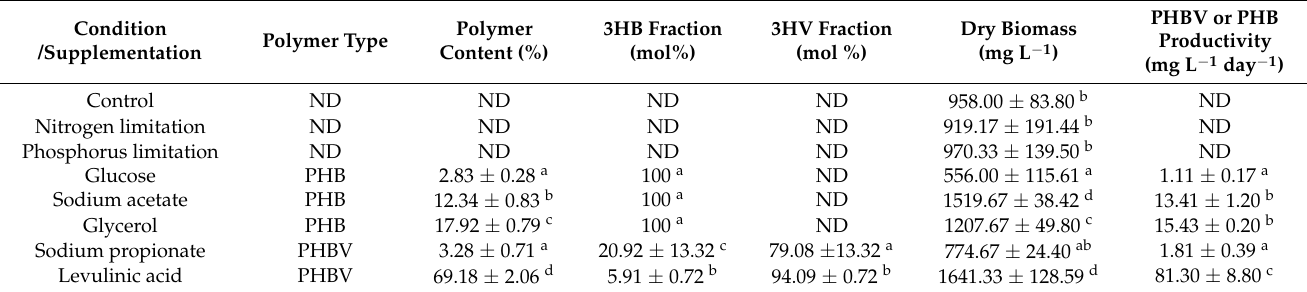
Table 4. PHBV production by Cyanosarcina sp. AARL T020 during second-stage cultivation under heterotrophic conditions for 14 days after optimizing the culture for 14 days. The contents of the 3HB and 3HV subunits were also identified after supplementation with 0.4% ( w / v ) of a carbon source influencing PHBV